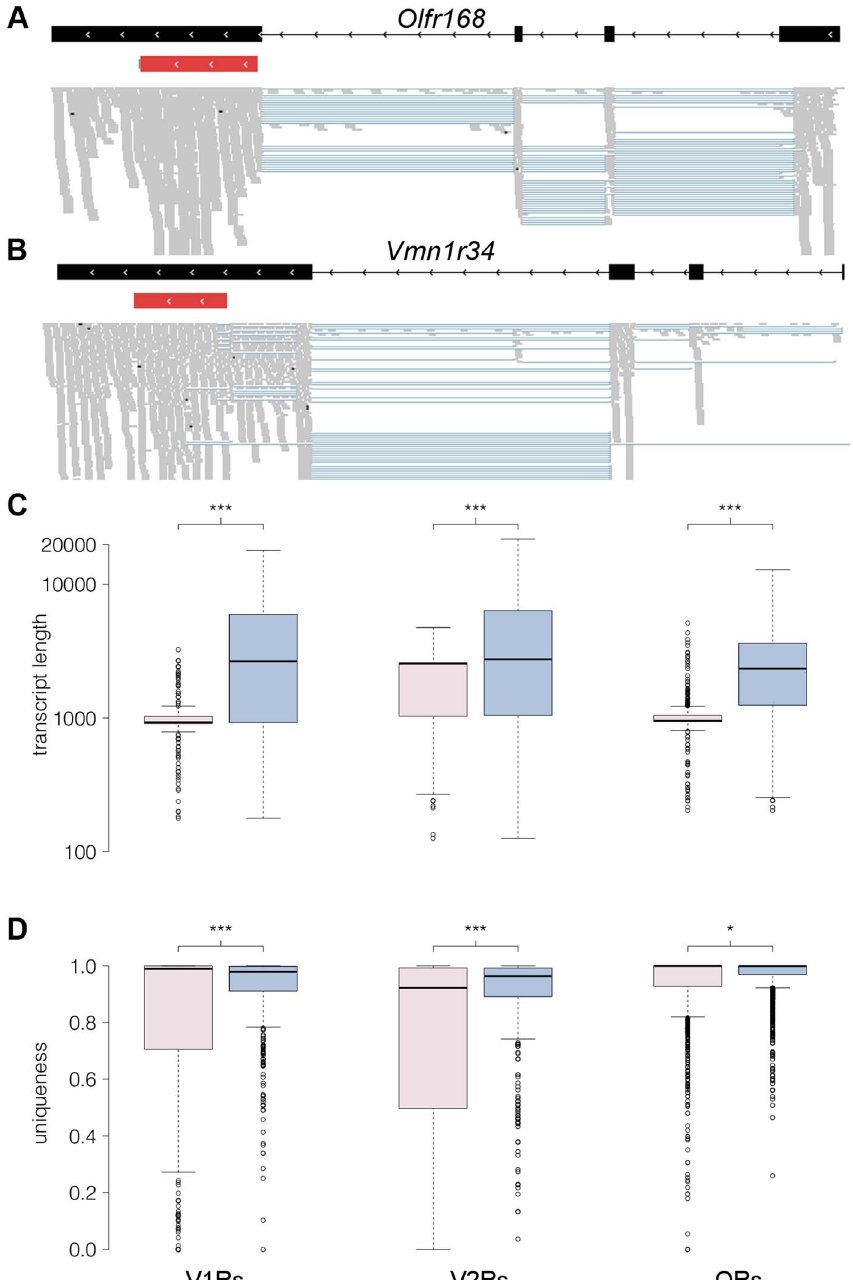
Figure 7. RNAseq provides comprehensive gene models for ORs and VRs. (A–B) An example of new gene models generated for Olfr168 (A) and Vmn1r34 (B) are shown in black. Boxes correspond to exons and arrowheads indicate the direction of the gene. The existing Ensembl annotations for the genes are shown in red with their UTRs in grey. New 5 9 exons and extended 3 9 UTRs were identified for both. The mapped RNAseq reads that support the models are below. Each read is drawn in grey and blue lines join read fragments that span exon junctions. Black segments within the reads indicate indels. (C) Boxplots of the transcript length as annotated in Ensembl (pink) or as obtained from the reconstructed models from our RNAseq data (blue) for the V1R, V2R and OR genes. The increase in transcript length is highly significant (*** P , 0.0001, two-tailed Mann-Whitney test). (D) As above, but quantifying the proportion of unique sequence for probe design (*** P , 0.0001 and *P , 0.01, two-tailed Mann-Whitney test). The uniqueness corresponds to the proportion of all 100 nucleotide long windows within the transcript that map uniquely to the genome. In all boxplots, outliers are defined as data points that fall outside 1.5 of the inter-quartile range, and are plotted as open circles.